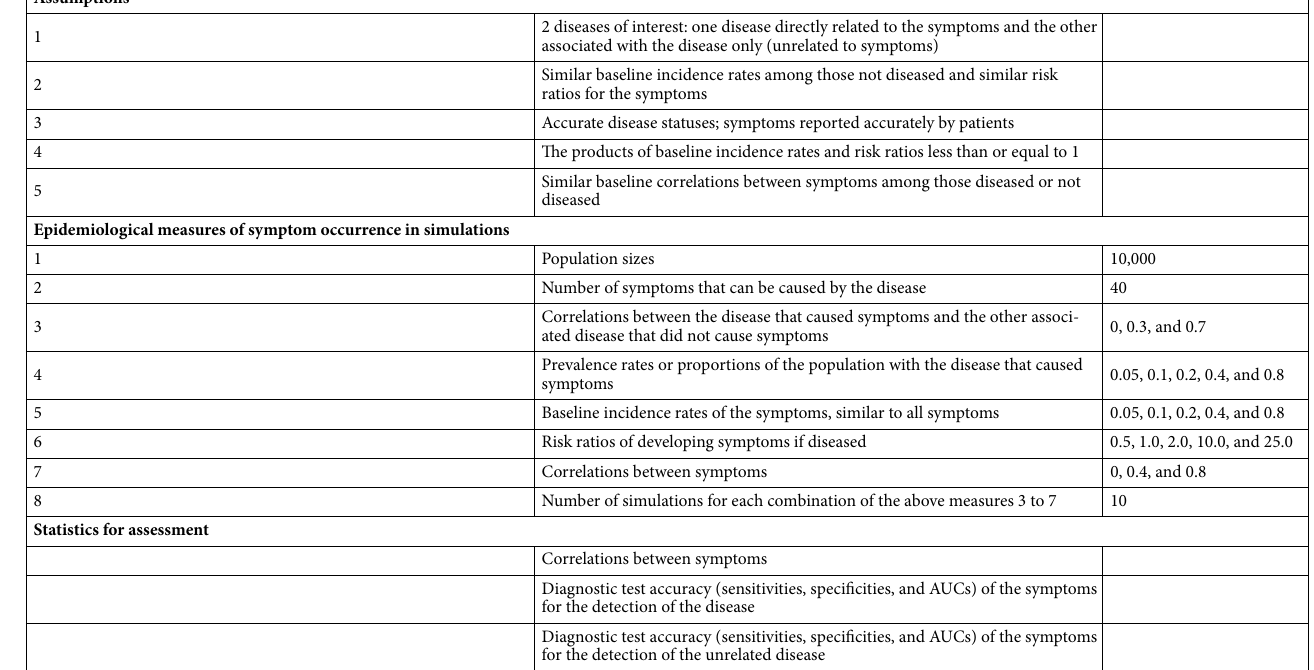
Table 3. Assumptions and the assessments of the simulated symptoms. AUC area under